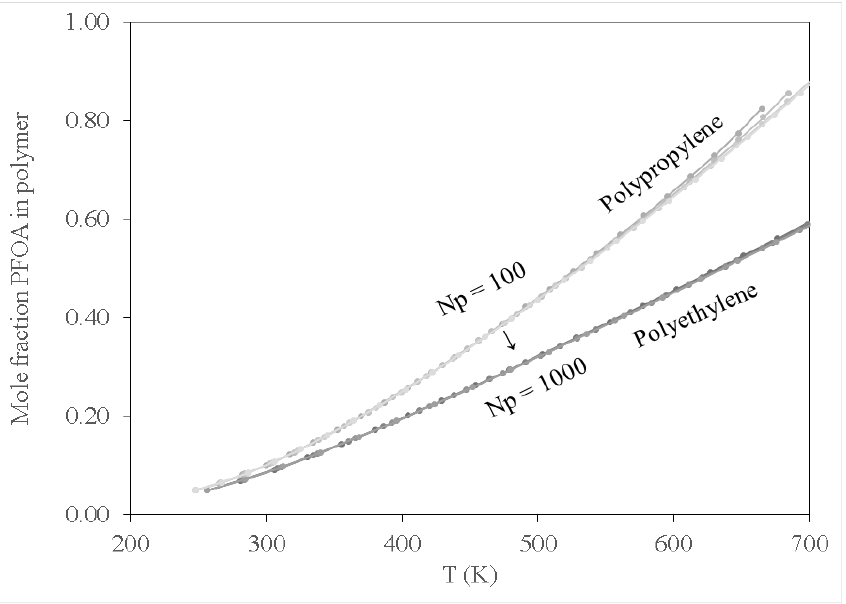
Figure 2. Effect of temperature on PFOA content of PP and PE with respect to the degree of polymer- isation (Np).